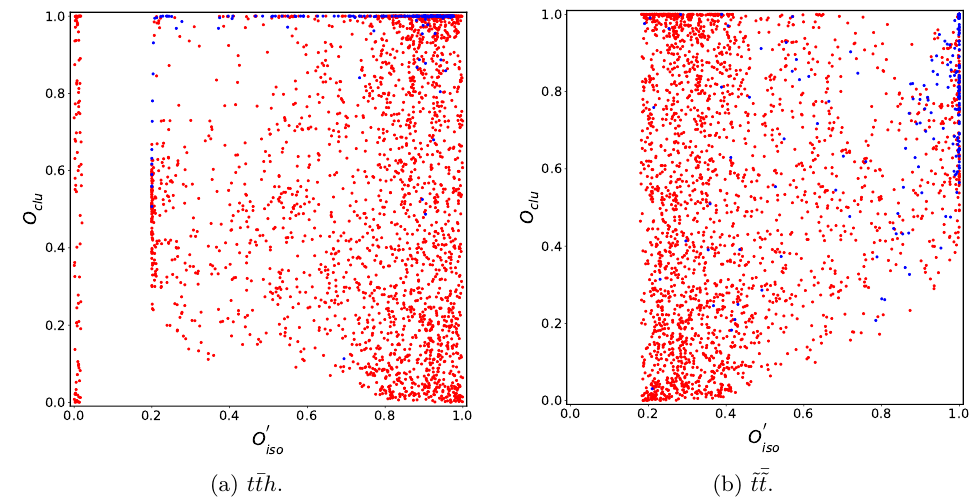
Figure 15 . Distribution of novelty scores for signal (blue points) and background (red points) in the O 0 − O clu plane. The signal events considered correspond to (a) t ¯ th and (b) ˜ t iso case, the bin resorting for O is trivial and hence we have O 0 iso